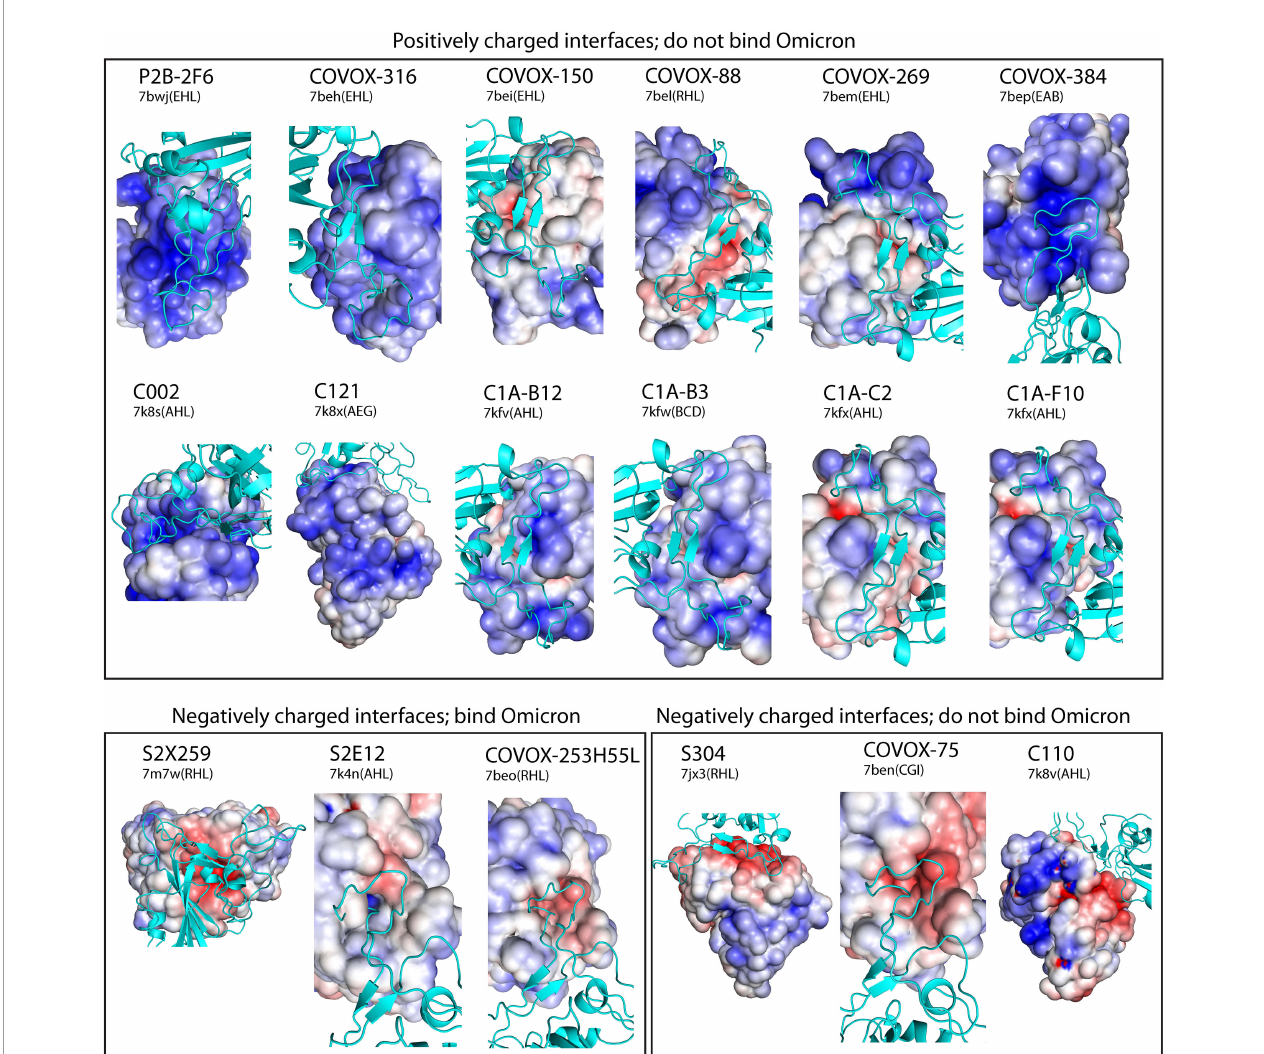
FIGURE 6 | Electrostatic surfaces of 18 neutralizing antibodies with experimental Omicron escape data. Solved reference Spike-antibody complexes were used to display antibody electrostatic surfaces at Spike (cyan) interacting sites, which are sorted into positive and negative surfaces that bind or do not bind Omicron S RBD based on experimental data. In solved complexes, all antibodies except S2X259 bind S RBM. Each complex is labeled by its antibody name and PBD ID(chains). The color scale of the electrostatic potential surface is in units of kT/e at T =